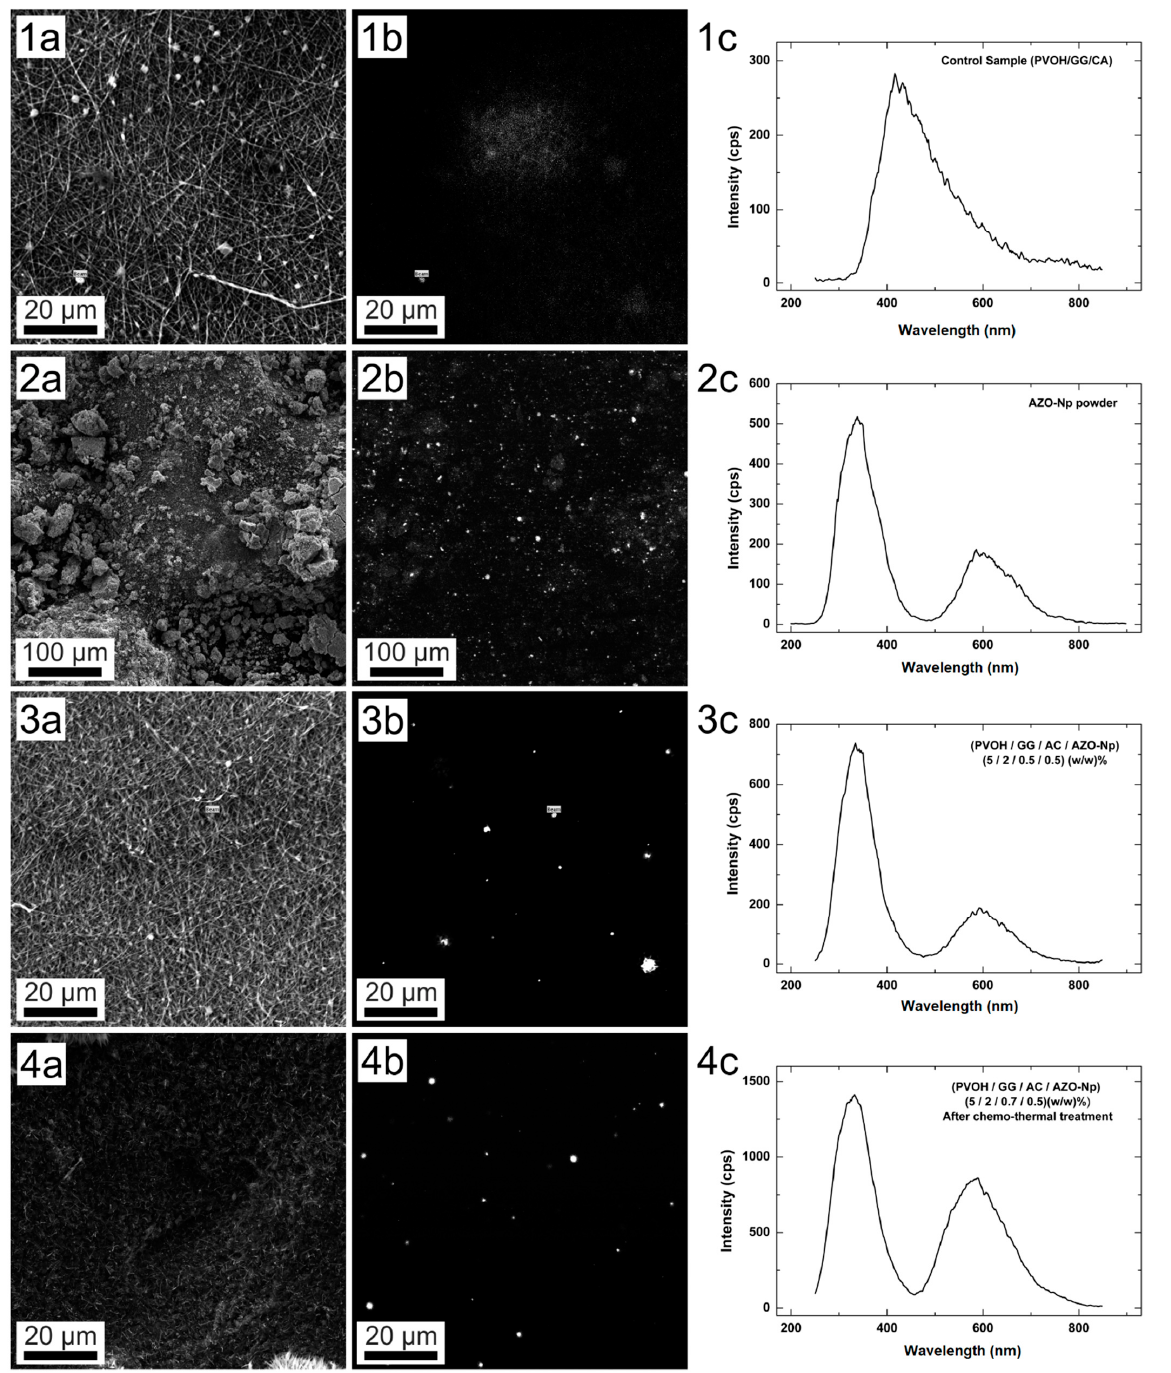
Figure 3. ( 1a ) SEM image of membrane without AZO-Np, 1 kX. ( 1b ) CL image of membrane without AZO-Np, 1 kX. ( 1c ) Cl point spectrum (intensity x wavelength), membrane without AZO-Np. ( 2a ) SEM image of AZO-Np powder, 200×. ( 2b ) Cl spectrum of AZO-Np powder, 200×. ( 2c ) Cl point spectrum (intensity × wavelength) of AZO-Np powder. ( 3a ) SEM image of acidic membrane (PVOH/GG/CA/AZO-Np) (PVOH (5/2/0.7/0.5) ( w / w ) %, 1 kX. ( 3b ) Cl spectrum of acidic membrane, 1 kX. ( 3c ) Cl point spectrum (intensity × wavelength) of acidic membrane. ( 4a ) SEM image of membrane (PVOH/GG/CA/AZO-Np) (5/2/0.7/0.5) ( w / w ) % after thermochemical treatment, 1 kX. ( 4b ) Cl spectrum of membrane after thermochemical treatment, 1 kX. ( 4c ) Cl point spectrum (intensity × wavelength) after thermochemical treatment, 1